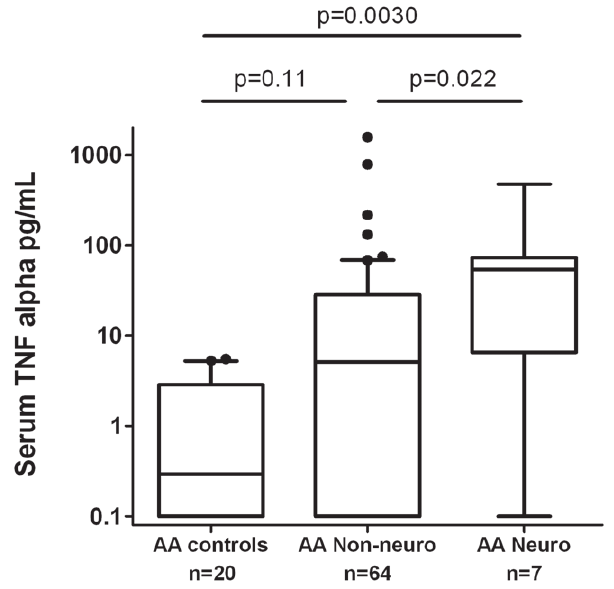
Figure 4. Serum type I IFN activity in European-American controls and sarcoidosis patients stratified by presence or absence of extra-pulmonary manifestations. Lines represent the median, boxes show the interquartile ranges, and error bars show the 10 th and 90 th percentiles with dots indicating outliers. P-values by Mann-Whitney U